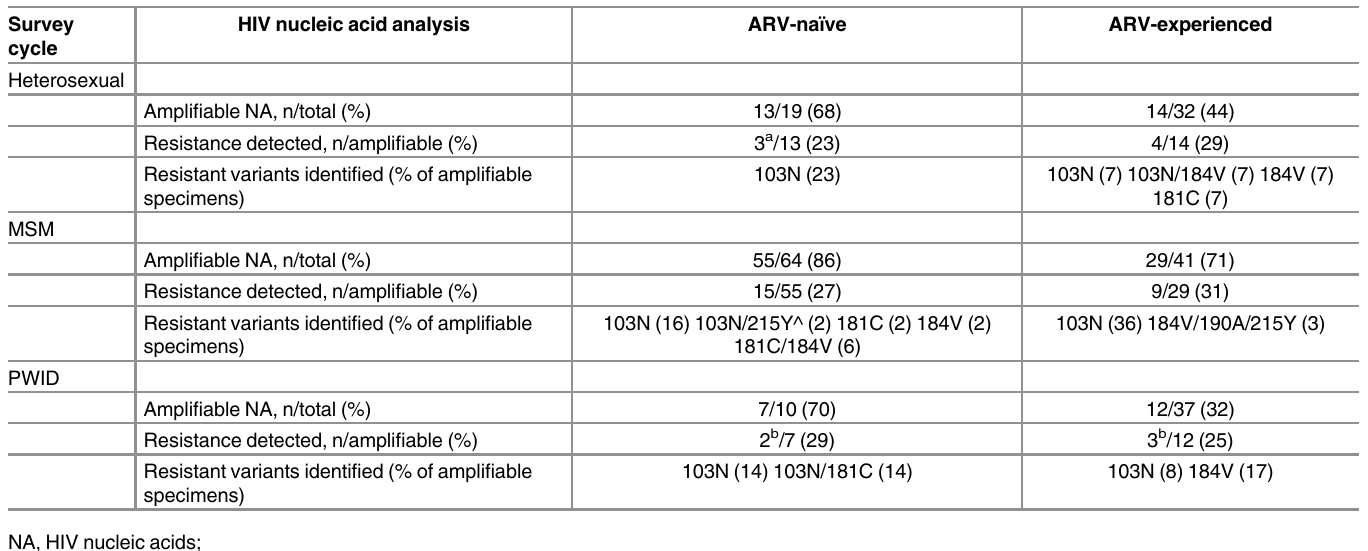
Transmitted and ARV-experienced drug resistance Antiretroviral drug resistance was assessed separately for persons self-reported as being ARV- naïve versus ARV-exposed. Nucleic acid recovery from specimens of ARV-naïve participants varied among the three cycles, with the greatest success in amplification for MSM (86%) and less for PWID (70%) and heterosexuals (68%) (Table 3). After recency testing, some blood cards did not have sufficient sample available for resistance testing and those participants were not included in the nucleic acid analyses. Table 3. Drug resistance mutation testing of DBS specimens. Survey